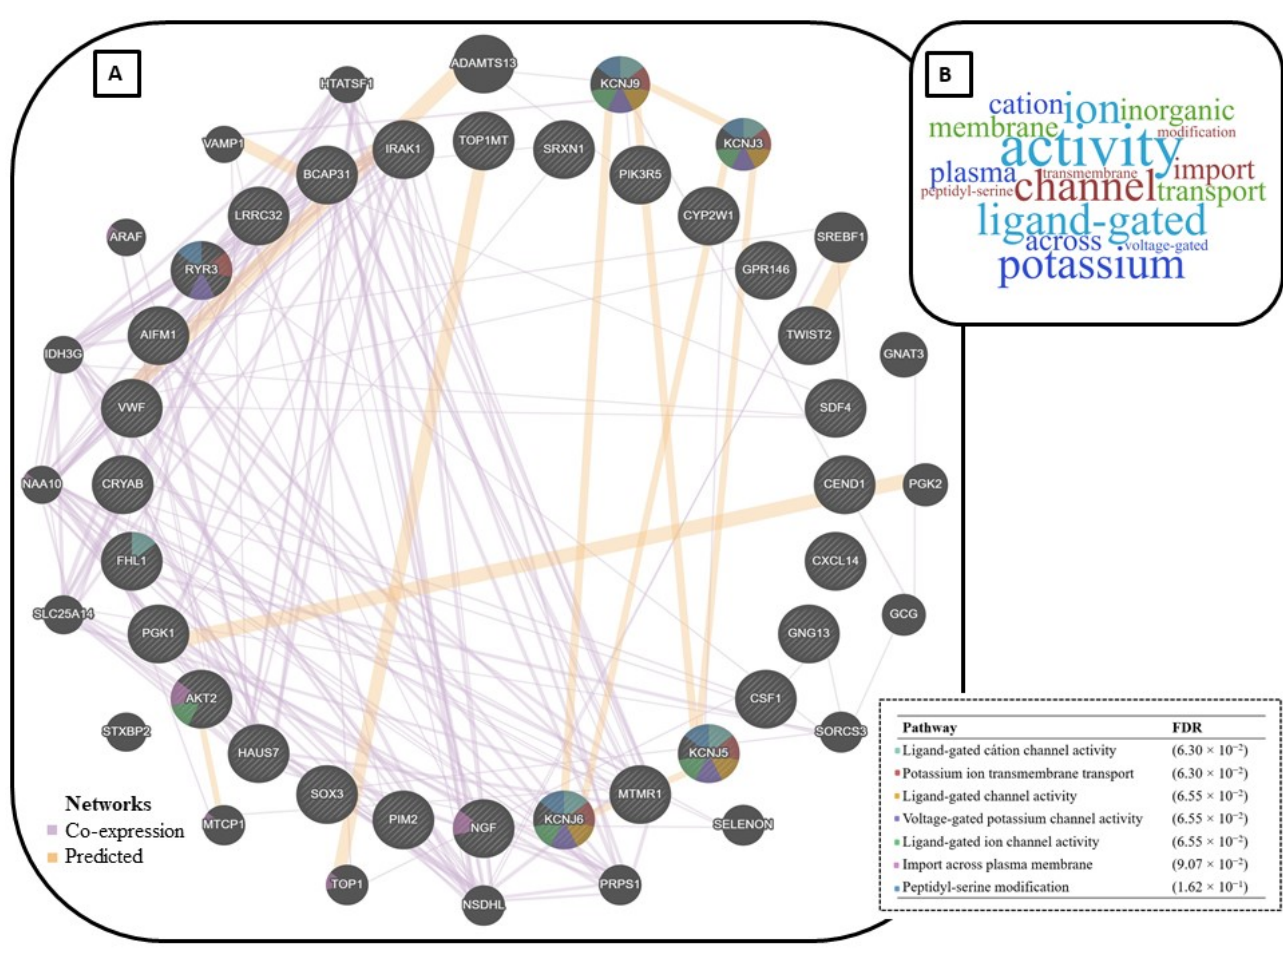
Figure 3. Prediction of the gene network ( A ) and most cited pathways ( B ) in which the genes play a role using the human genome as a reference. Table 2. Effect of stress on pigs’ genome subjected to different environmental insults. The approaches used to access the methylated DNA was whole genome bisulfite sequencing (WGBS) or reduced representation bisulfite sequencing